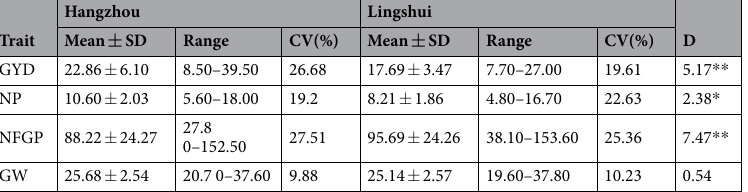
Table 1. Summary statistics of grain yield and yield components in two experiment locations. GYD = grain yield; NP = number of panicles per plant; NFGP = number of filled grains per panicle; GW = grain weight; CV = coefficient of variation; D = the difference in mean between two experimental locations; * p ≤ 0.05; ** p ≤